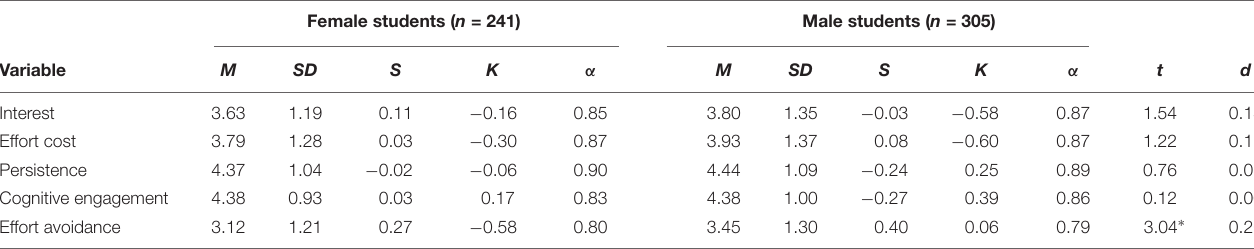
TABLE 5 | Descriptive statistics and mean difference by